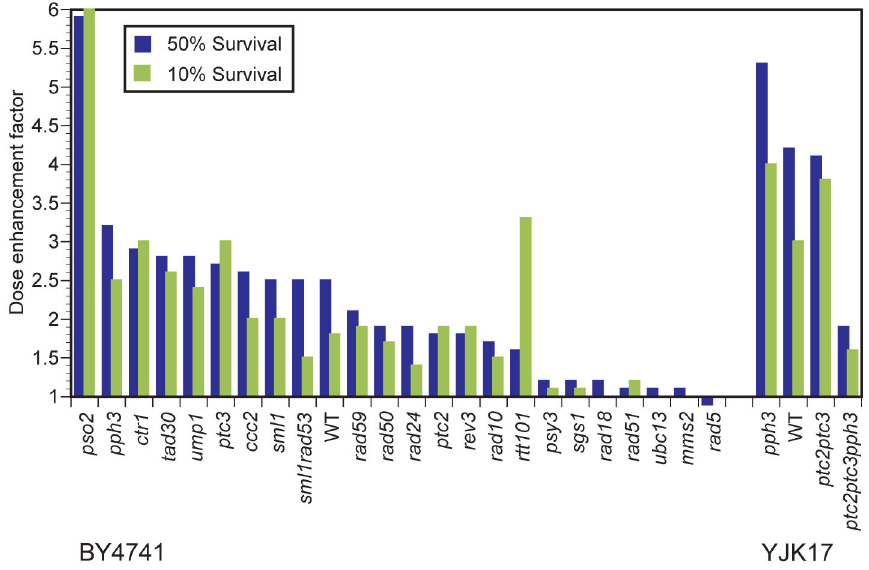
Figure 2. Effect of NSC109268 on cisplatin sensitivity in various deletion mutants. Strains of two different genetic backgrounds (BY4741, YJK17) were ranked by dose enhancement factors at 50% survival. Data were corrected for inactivation by NSC109268 alone. See Table S1 for the putative role of gene